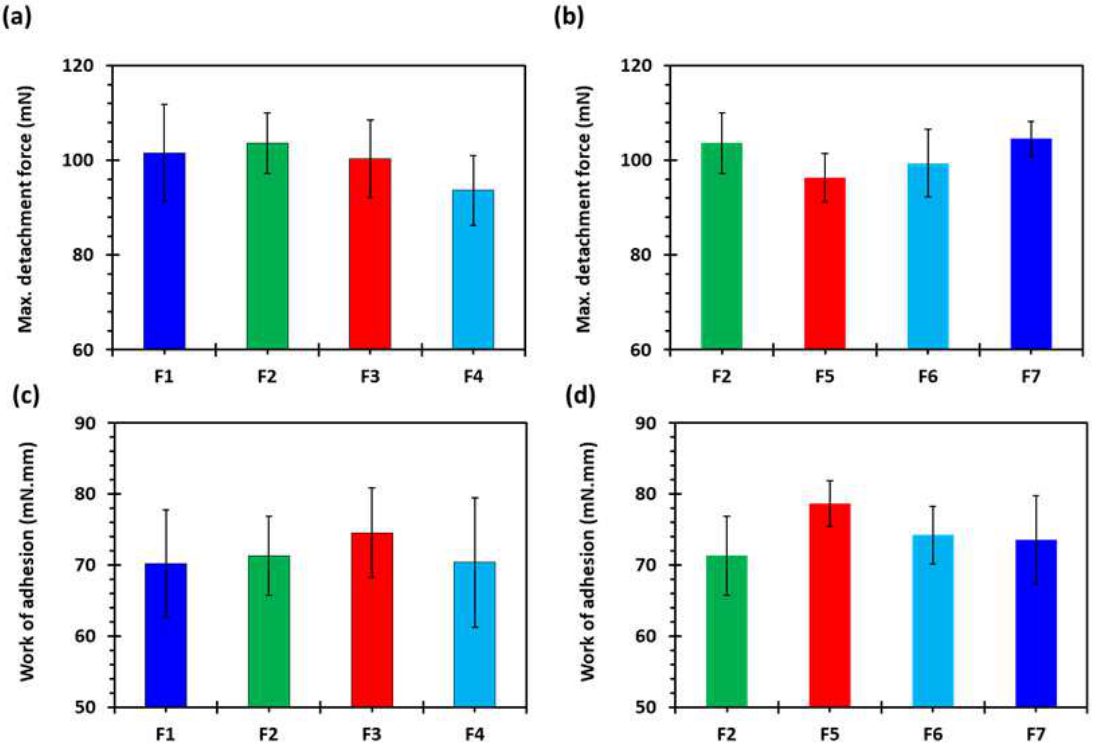
Figure 9. ( a , b ) Maximum mucoadhesion detachment force and ( c , d ) work of adhesion against por- cine stomach mucosa in 0.1 N HCl at 37 ± 0.5 °C (n = 3): F1 (1 shell with 0% infill); F2 (2 shells with 0% infill); F3 (3 shells with 0% infill); F4 (4 shells with 0% infill); F5 (2 shells with 10% infill); F6 (2 shells with 20% infill); and F7 (2 shells with 30% infill).